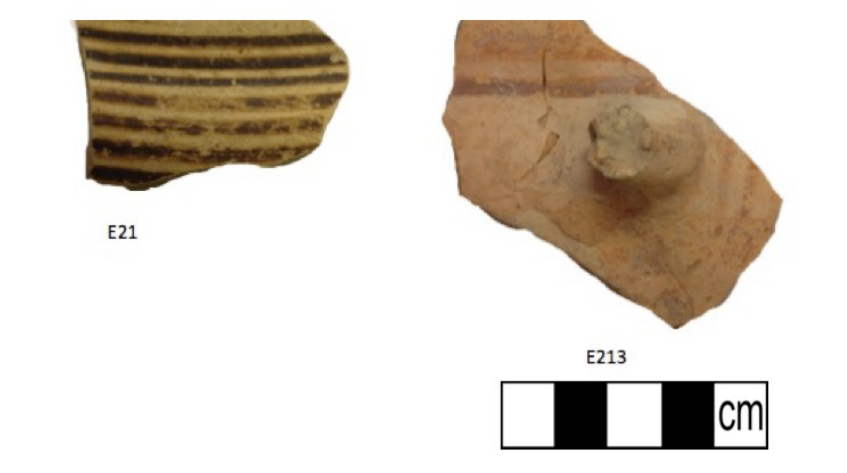
Figure 4. Proto-corinthian cups E21 and